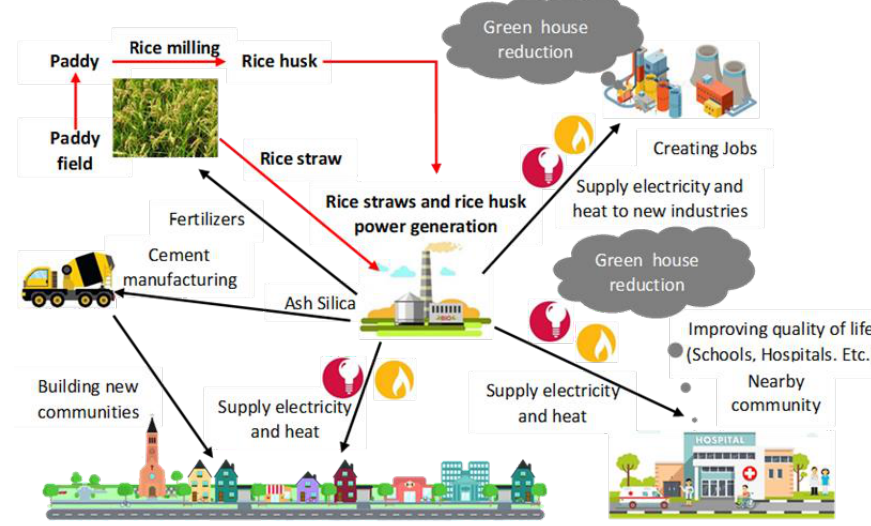
Figure 9. Business associated with RS and RH power plants.